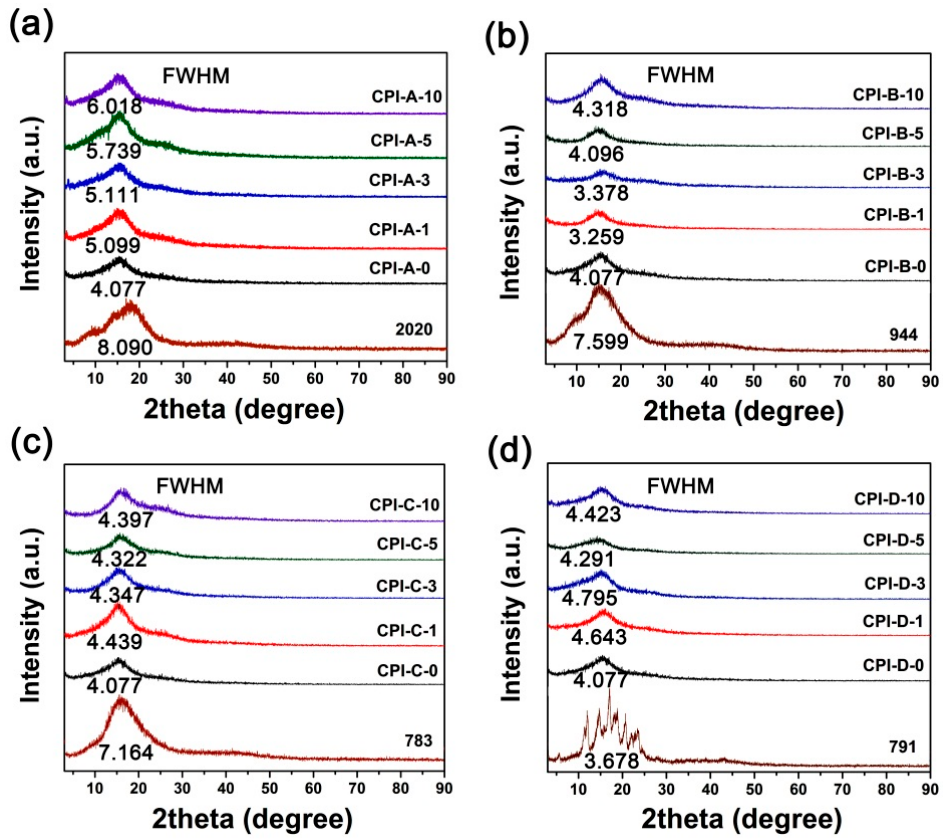
Figure 8. XRD plots of CPI/HALS nanocomposite films. ( a ) CPI-A; ( b ) CPI-B; ( c ) CPI-C; ( d ) CPI-D.